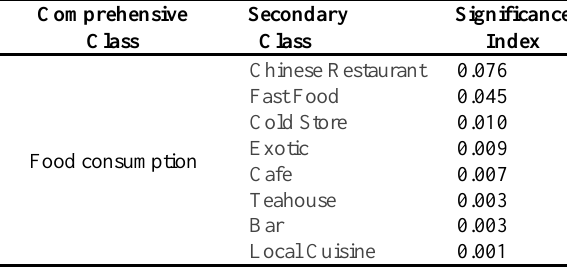
Table 5. Significance ranking of Food Consumption